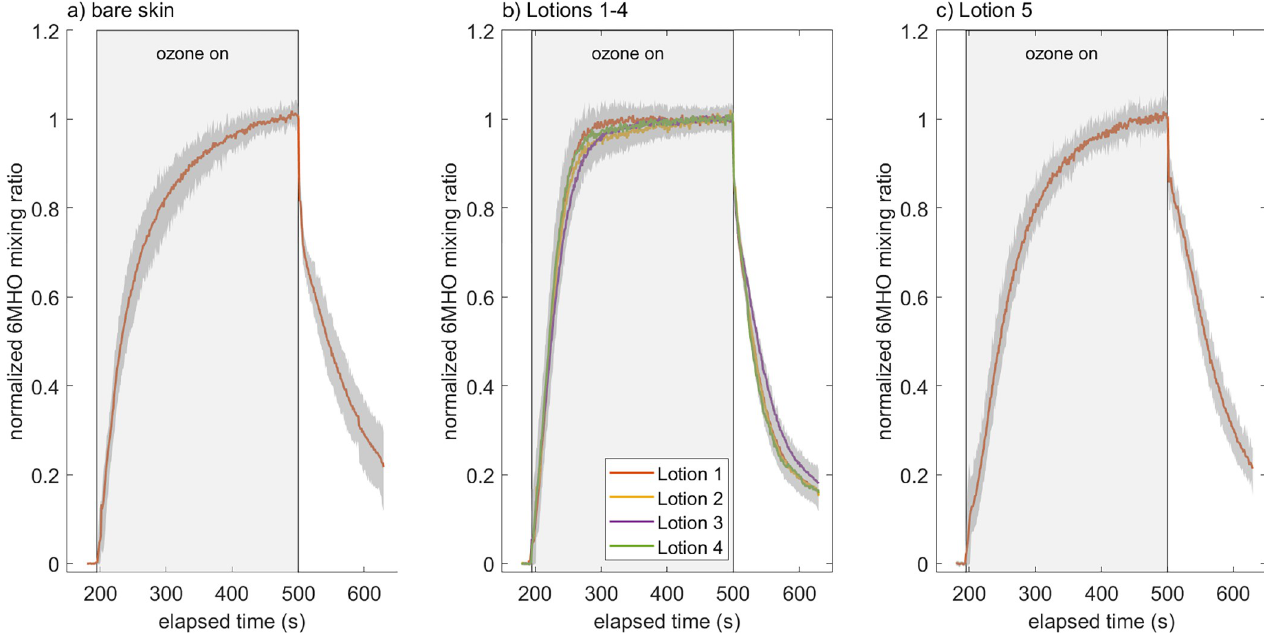
Fig 5. Dynamic emissions of 6MHO. Dynamic 6MHO signal before, during and after ozone exposure to skin, normalized by signal during the last 10 seconds of ozone exposure and averaged over all participant results. a) bare skin, b) Lotions 1–4, c) Lotion 5. Grey shaded square represents time period with ozone exposure. Darker grey shade around 6MHO curves represents 10 th to 90 th percentile